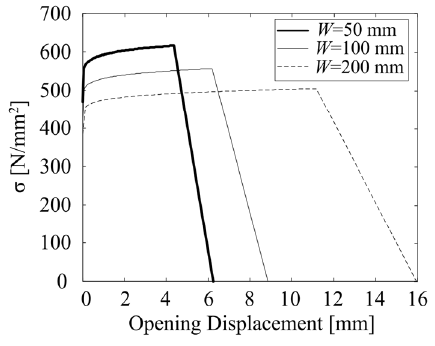
Figure 14. Hardening cohesive/overlapping laws for different specimen sizes.